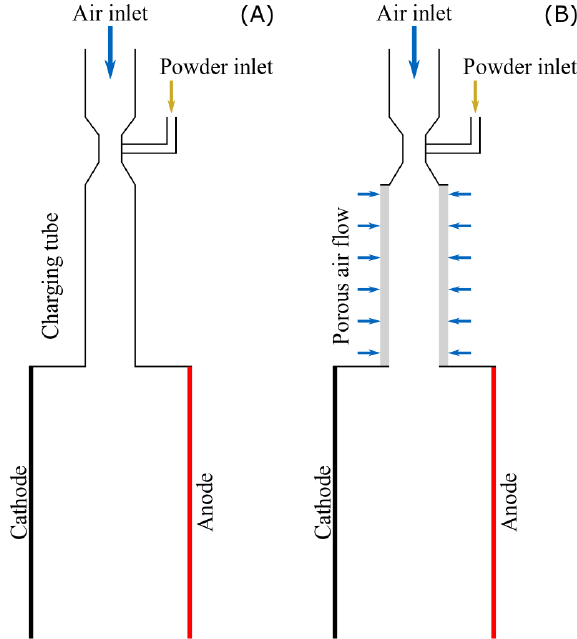
Figure 1. Scheme of the used dispersing, charging and separation setup with plain wall ( A ) and porous tube to adjust boundary-layer control ( B ). After the charging tube, particles are separated in a homogenous electrical field and particles are precipitated on the